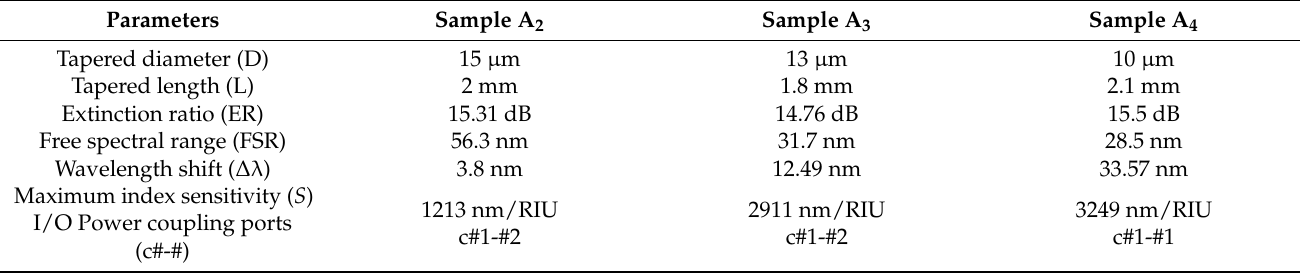
Table 1. Working parameters for TFCF-based RI